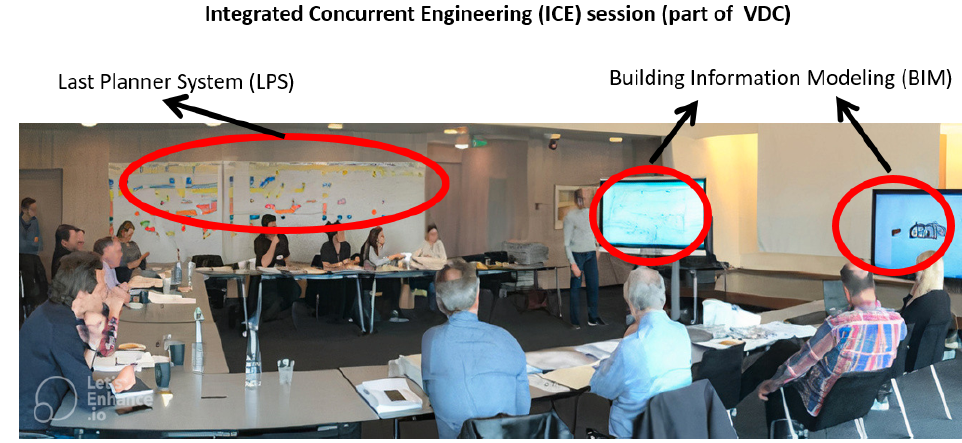
Figure 5. ICE session in the Big Room, adapted from [37], Roar Fosse: IGLC 2017.